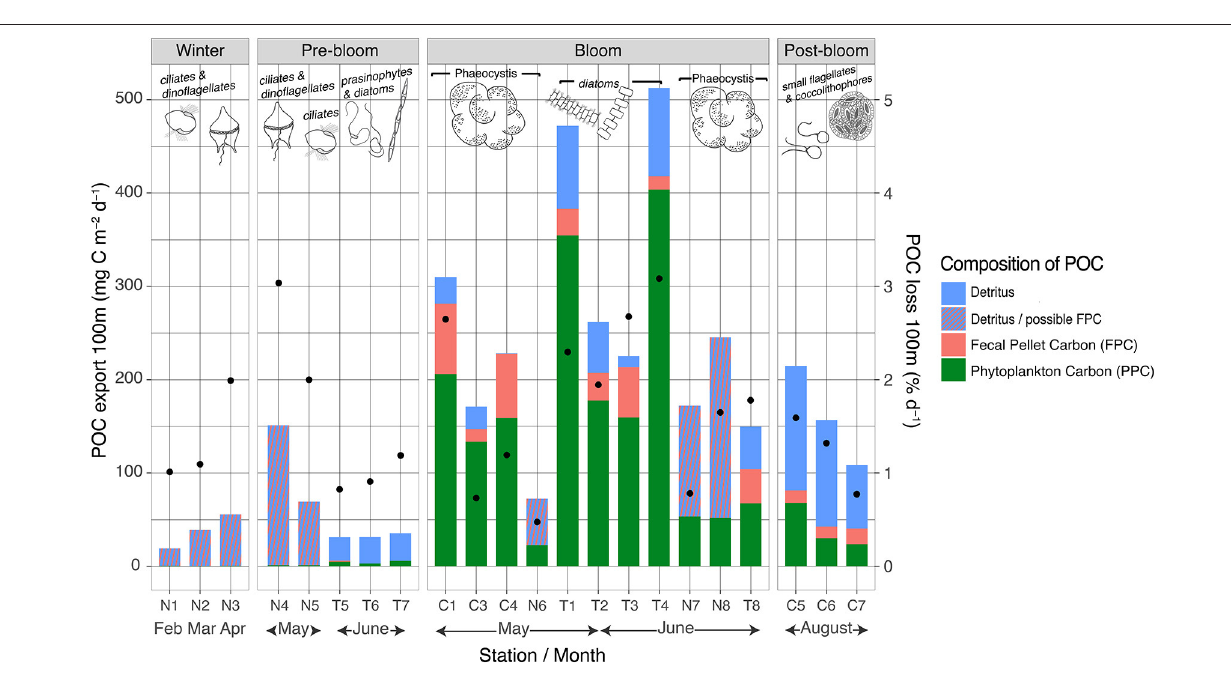
had higher 100 m export fluxes. At station N4, these fluxes translated into a high daily POC loss rate of 3% day − 1